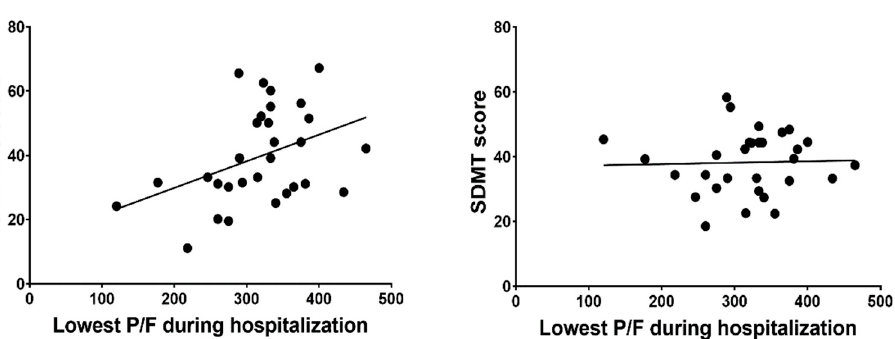
Figure 1. P/F = arterial oxygen partial pressure (PaO 2 )/fractional inspired oxygen (FiO 2 ) ratio; SRT-LTS = Serial Recall Test Long-Term Storage; SDMT = Symbol-Digit Modalities Test.